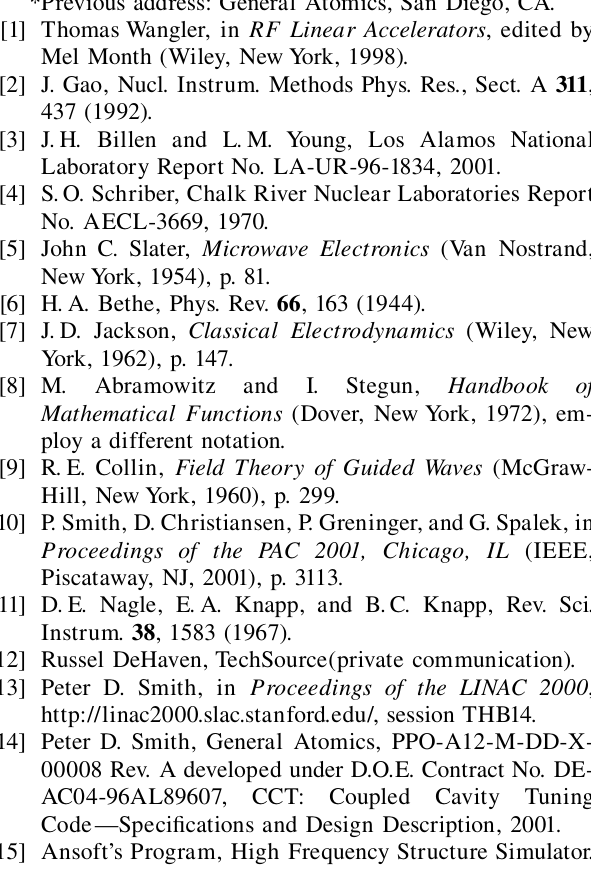
FIG. 4. Coupling cavity details. Additional figures may be found in the Poisson SUPERFISH manual [3]. The parameter F , which specifies the nose height flat section, is assumed to be